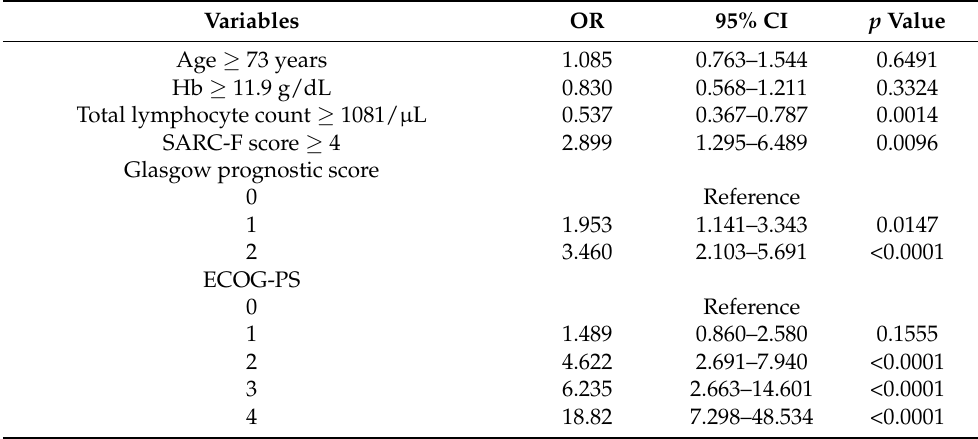
Table 3. Multivariate analyses of factors associated with the overall